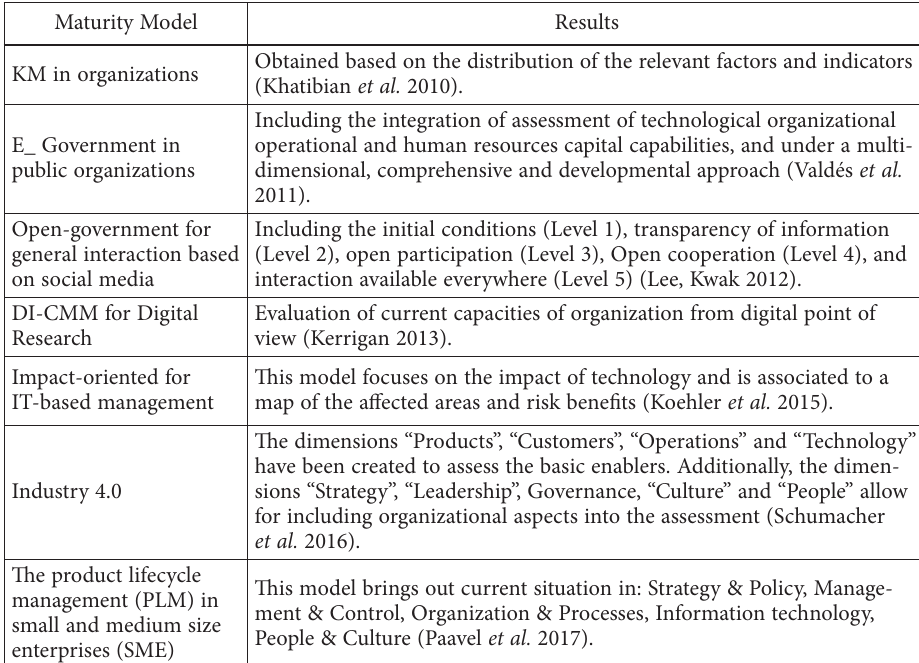
Table 2. Important researches on assessing